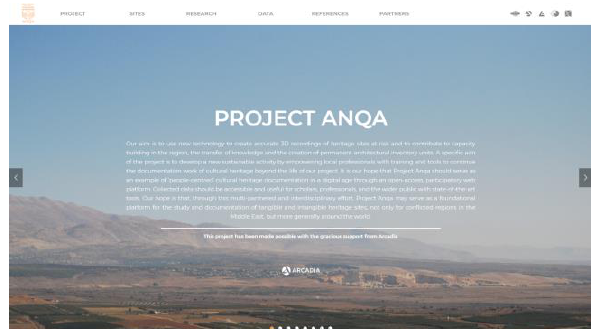
Figure 1. Anqa Project – Home